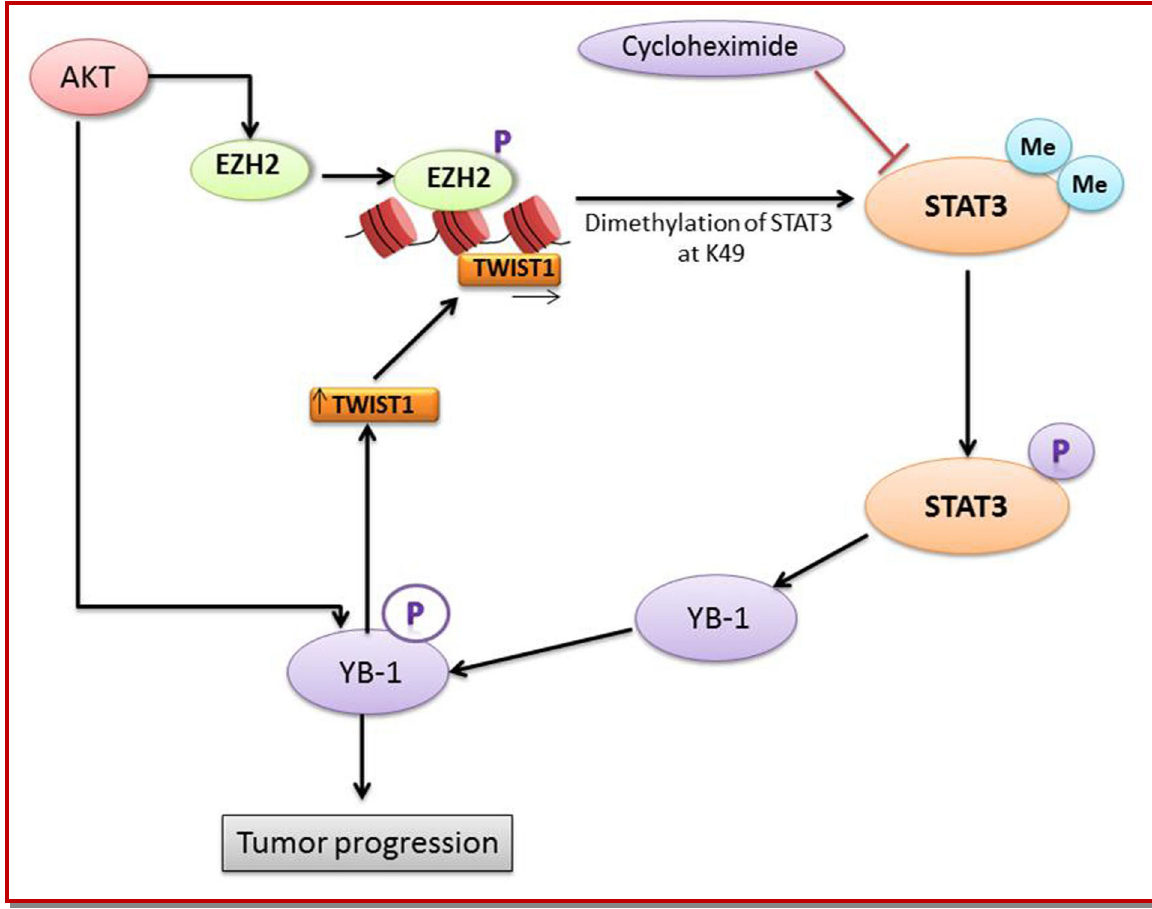
Figure: 3 Role of YB-1 in metastasis Twist1 regulates AKT2 gene expression and might be involved in AKT1 regulation which is involved in YB-1 phosphorylation and metastasis (Shiota et al.,